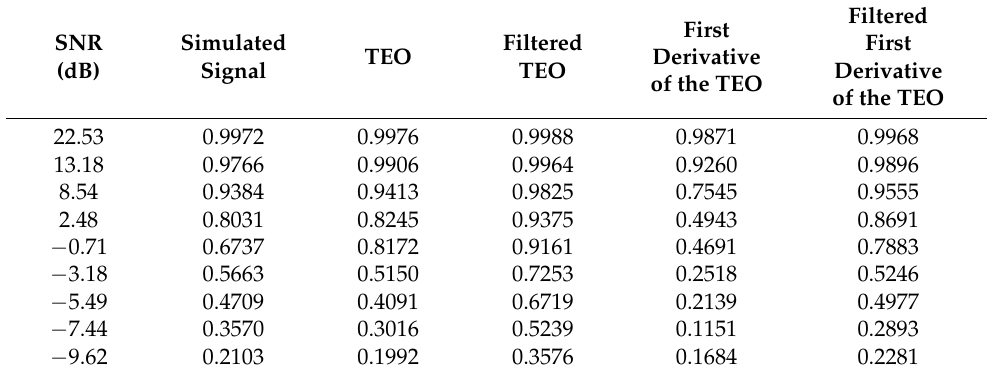
Table 1. Correlation of preprocessed impulses and expected impulses with different SNRs.